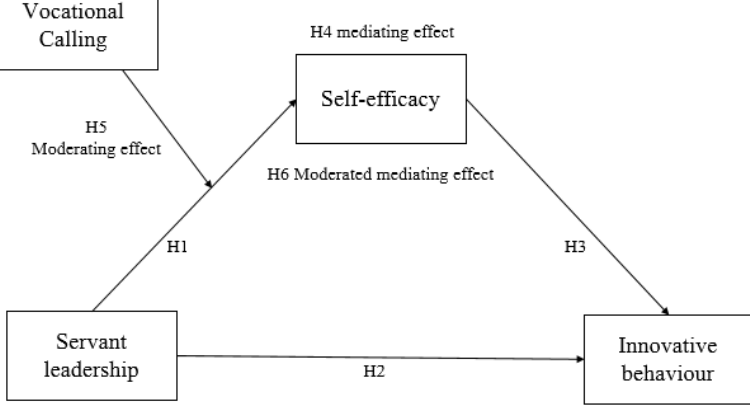
Figure 1. Research Figure 1. Research model.